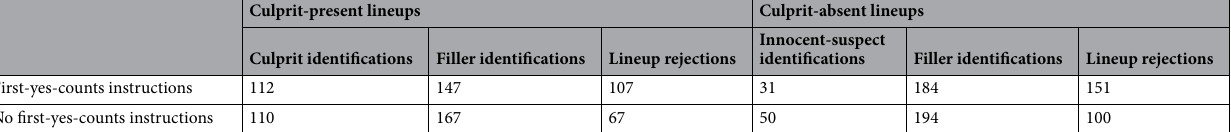
Table 2. Response frequencies obtained in the conceptual replication of the sequential-lineup conditions of Horry et al. 32